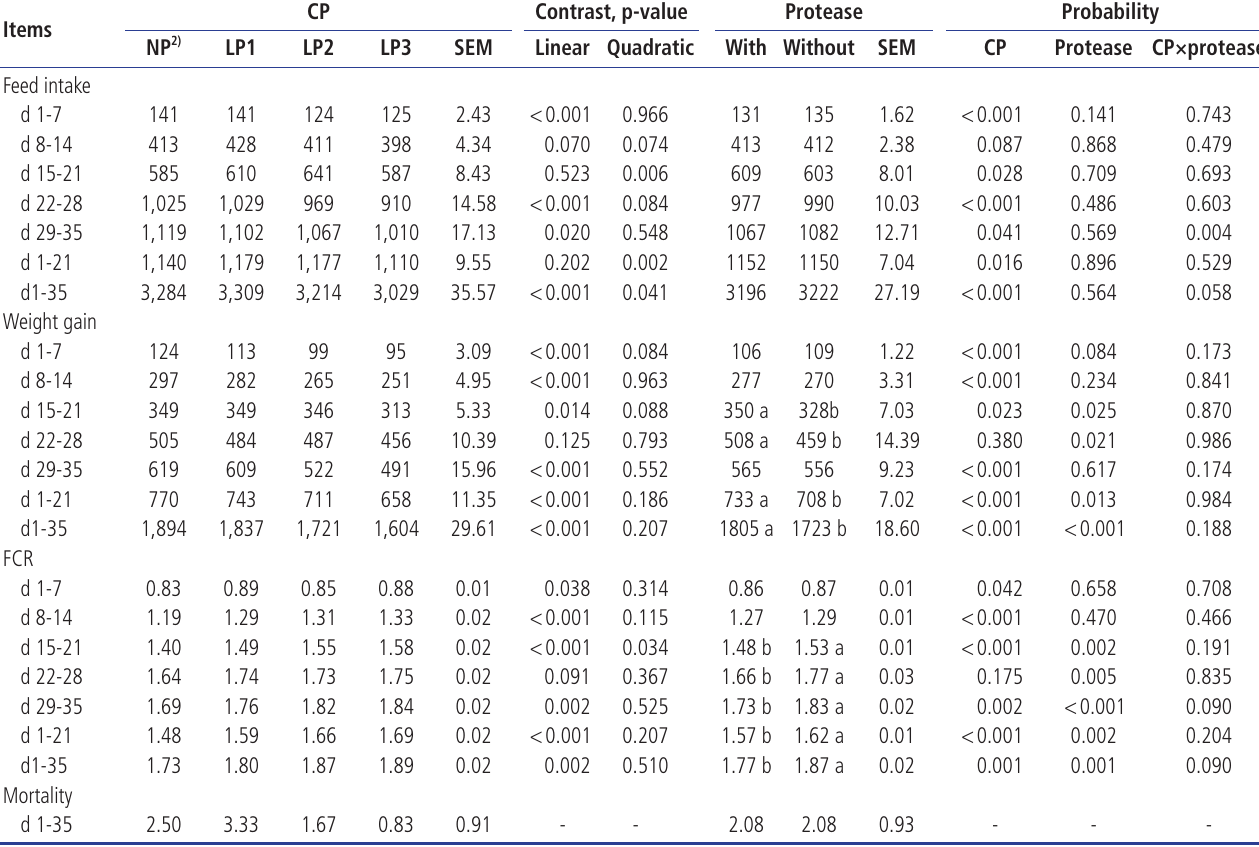
Table 2. Effect of crude protein level and protease enzyme supplementation on growth performance in broiler chickens from day 1-35 1)